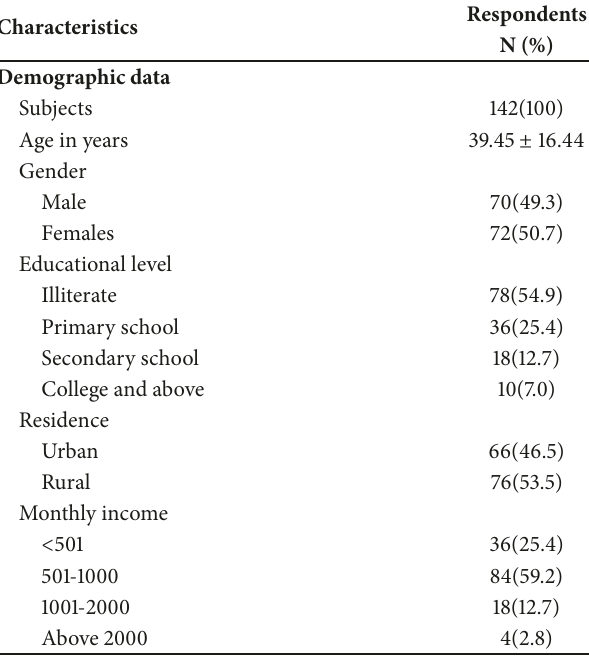
Table1:SociodemographiccharacteristicsofpatientsatJimmaUni- versity Specialized Hospital, South West Ethiopia, February–Sep- tember, 2014